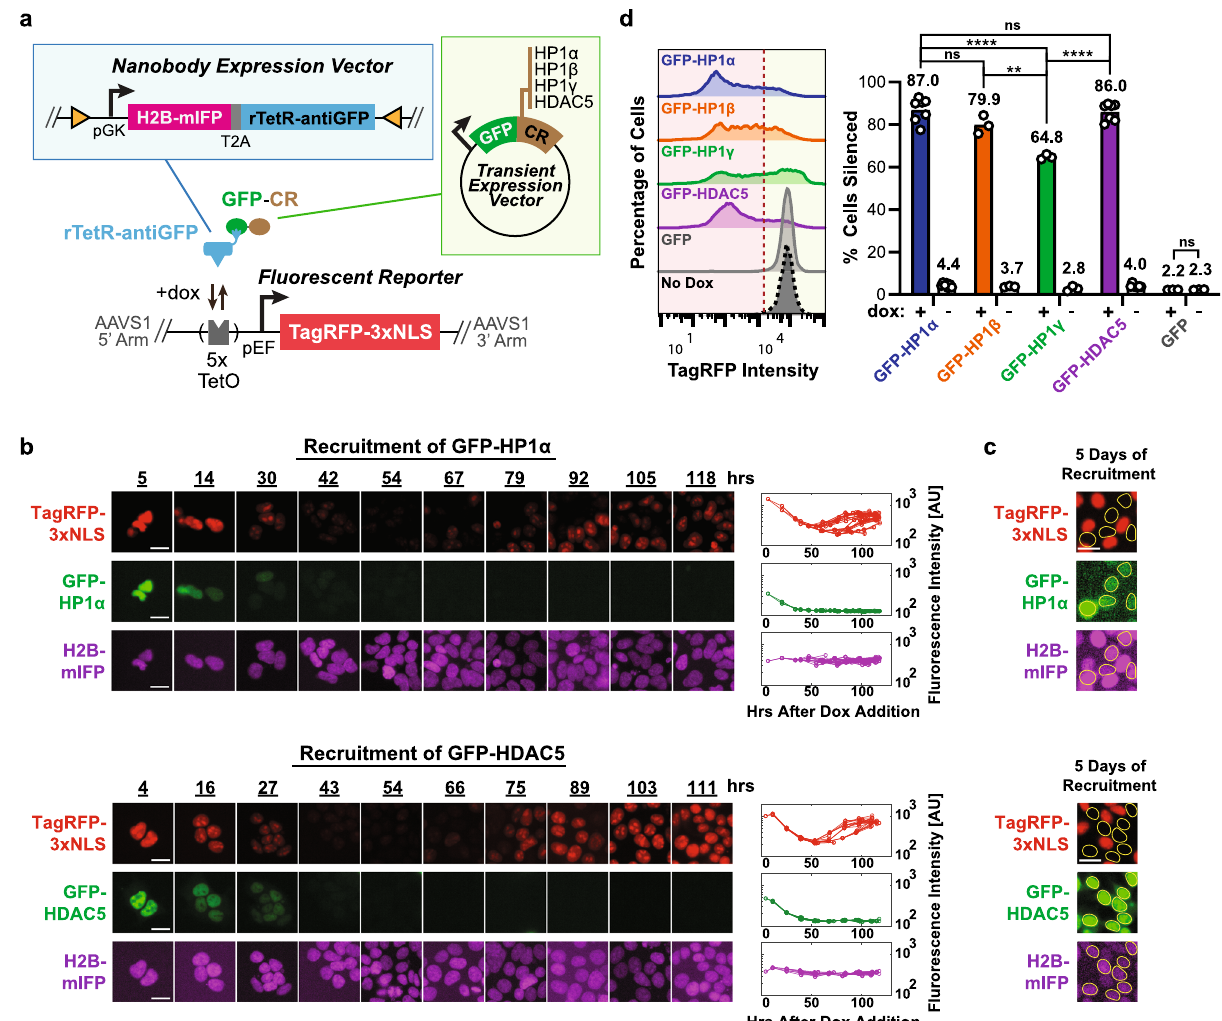
Fig. 1 Nanobodies against GFP-tagged chromatin regulators allow for gene expression control. a Construct for constitutive coexpression (under the pGK promoter) of H2B-mIFP and antiGFP nanobody fused with the rTetR DNA-binding protein (separated by the self-cleaving peptide T2A) was randomly integrated into HEK293T cells by PiggyBac (blue box, top). These cells also contain a TagRFP reporter gene integrated at the AAVS1 “ safe harbor ” locus and driven by the pEF promoter (bottom). Five TetO-binding sites allow binding of rTetR upstream of the reporter gene upon dox addition. The nuclear localization signal (NLS) and H2B domains localize fl uorescent protein signals to the nucleus, improving quanti fi cation during time-lapse imaging. Plasmids expressing GFP-tagged CRs (HP1 α , HP1 β , HP1 γ , and HDAC5) were transiently transfected into cells (green box, right). b Time-lapse imaging of cells upon recruitment of GFP-tagged HP1 α (top) and HDAC5 (bottom). Cells stably expressing the reporter (TagRFP, red) and the rTetR-antiGFP fusion (mIFP, purple) were transiently transfected with GFP-HP1 α or GFP-HDAC5 (GFP, green). Cells were treated with dox throughout the movie starting at time 0 hours. Example images across the time-lapse movie (left) and single-cell traces for individual cell lineages as they undergo up to eight cell divisions (right). c Cells that still have GFP-CR expression (yellow circles) by day 5 of recruitment remain silenced. Images and analysis in b and c from one biological replicate. Scale bars: 20 μ m. d Left: fl uorescence distributions measured by fl ow cytometry showing reporter silencing after recruitment of GFP- CRs ( + dox) for 5 days. Cells were gated for the presence of both GFP-CR (GFP positive) and rTetR-antiGFP (mIFP positive). The red dotted line was used to determine the percentage of cells silenced shown on the right. Right: mean percentage of cells silenced upon presence or absence of dox for 5 days. Each dot is an independently transfected biological replicate (GFP-HP1 α : n = 7; GFP-HP1 β : n = 3; GFP-HP1 γ : n = 3; GFP-HDAC5: n = 7; GFP: n = 3). Statistical analysis by two-tailed Tukey ’ s test (GFP-HP1 α vs. GFP-HP1 γ : **** p = 4.8e − 6; GFP-HP1 β vs. GFP-HP1 γ : ** p = 0.0031; GFP-HP1 γ vs. GFP-HDAC5: **** p = 9.0e − 6). Source data are available in the Source Data fi